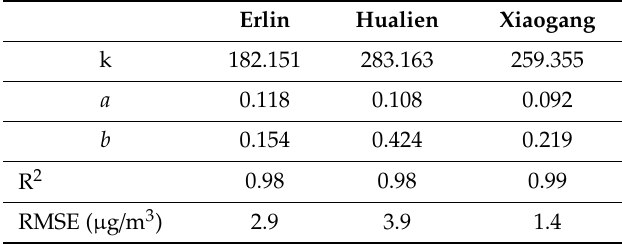
Table 1. R 2 , root-mean-square error (RMSE), and coe ffi cients (k, a, b) of the concentration–duration– frequency (CDF) empirical